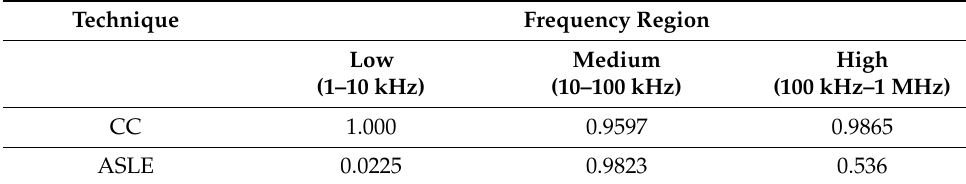
Table 12. Numerical technique for H3-H2 vs.